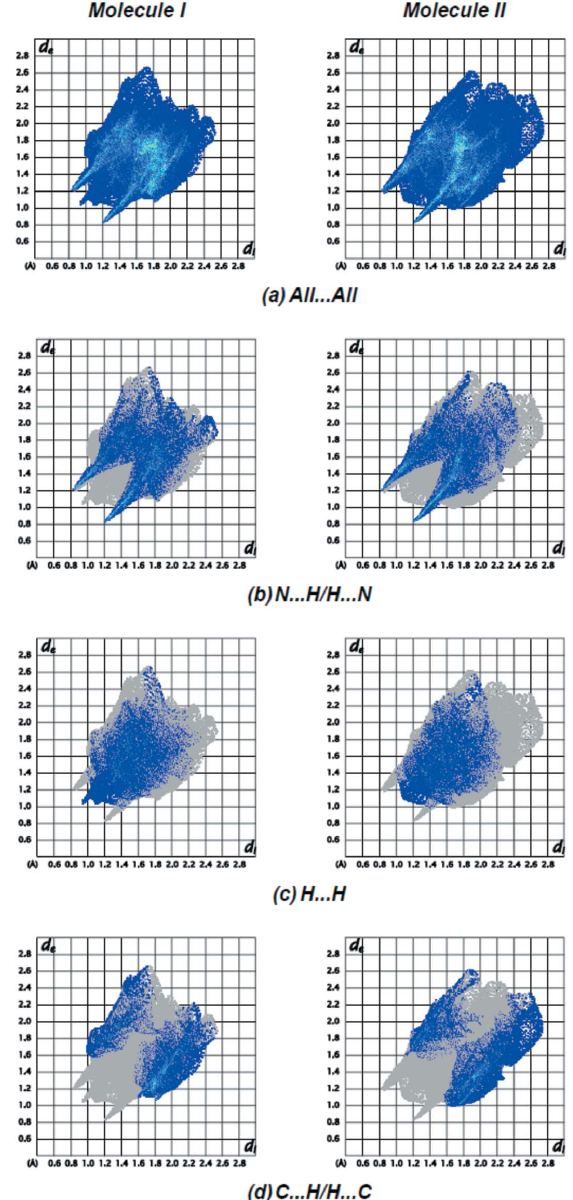
Figure 8 Two-dimensional fingerprint plots for molecules I and II of the title compound, showing ( a ) all interactions, and delineated into ( b ) N (cid:2)(cid:2)(cid:2) H/ H (cid:2)(cid:2)(cid:2) N, ( c ) H (cid:2)(cid:2)(cid:2) H and ( d ) C (cid:2)(cid:2)(cid:2) H/H (cid:2)(cid:2)(cid:2) C interactions. The d i and d e values are the closest internal and external distances (in A˚ ) from given points on the Hirshfeld surface.